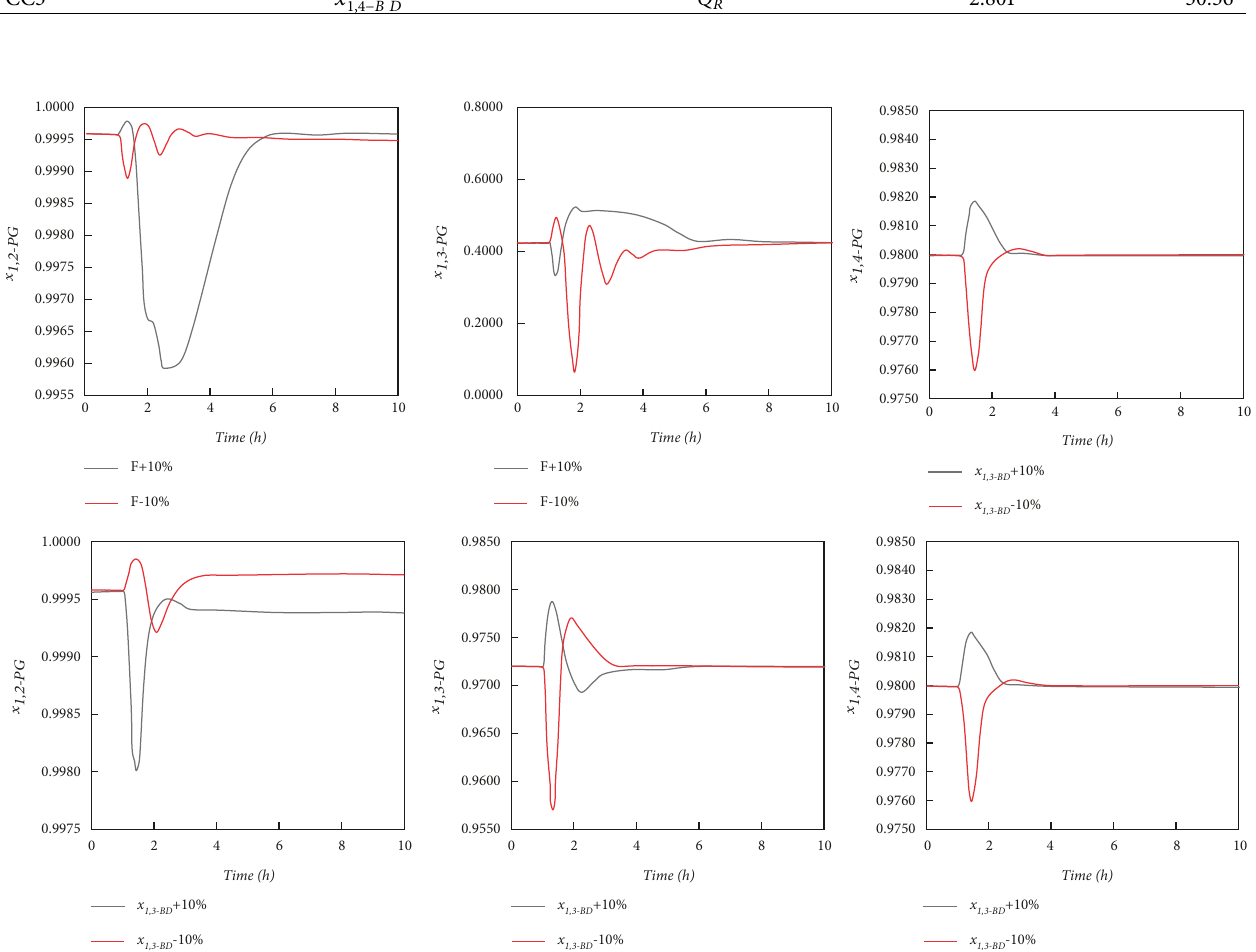
Figure 6: Dynamic responses of CS2 to ± 10% feed